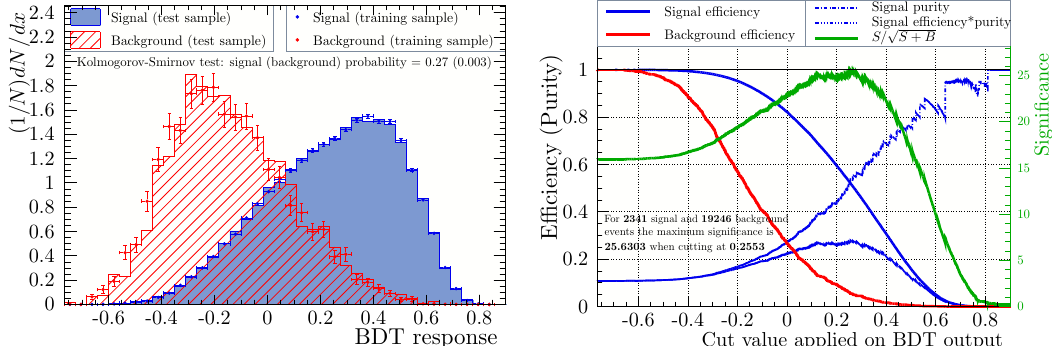
Signal (training sample) Background (training sample)